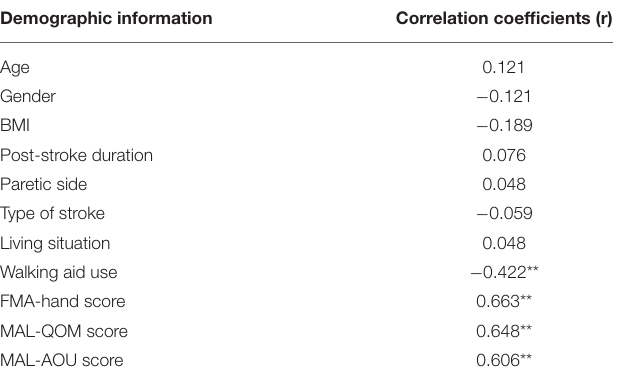
TABLE 2 | The correlation between ARAT score and the other variables.